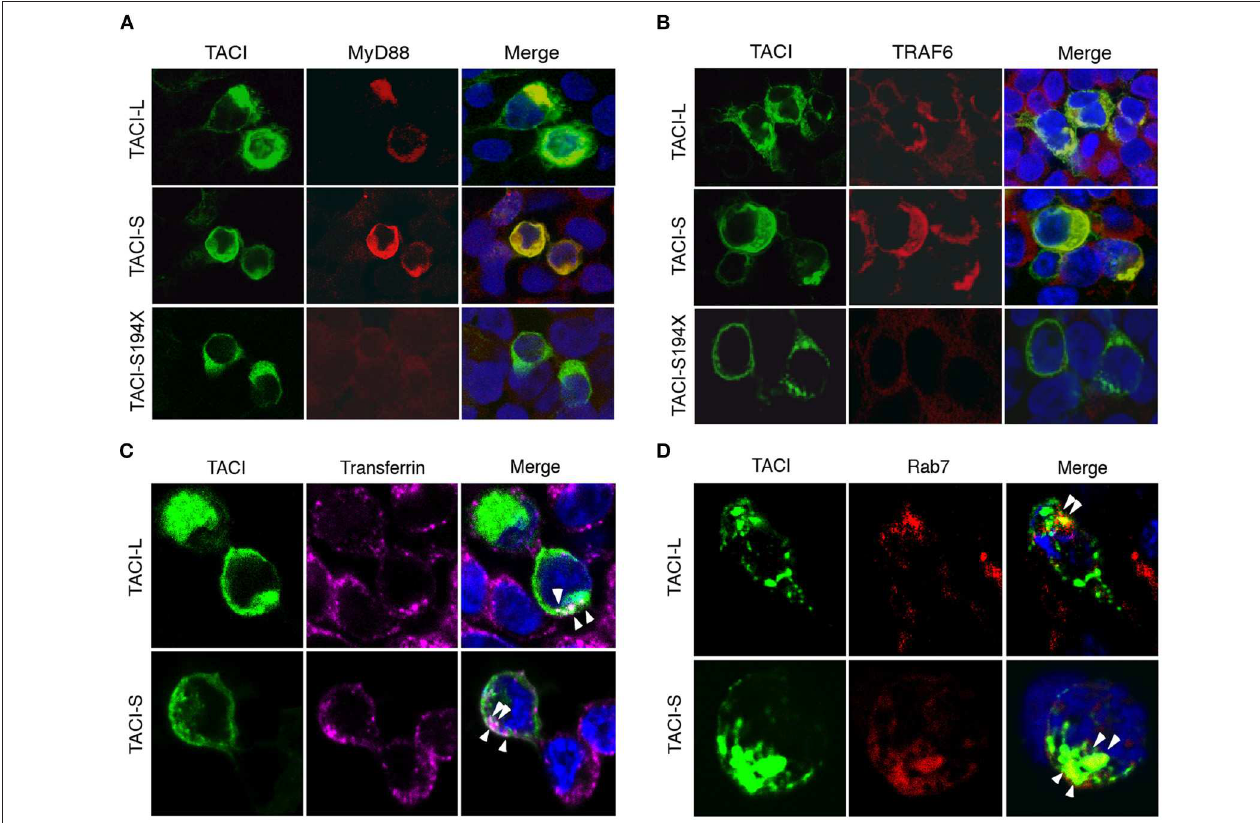
FIGURE 5 | TACI co-localizes with MyD88 and TRAF6 in the late endosomal compartment. (A) mCherry labeled TACI-S, TACI-L or TACI-S194X isoform transfected HEK-293T cells, were stained with rabbit Ab to MyD88 or TRAF6; nuclei were stained with DAPI. Merged images show that each TACI isoform co-stains with MyD88 (A) and TRAF6 (B) , but colocalization is absent for the S194X mutant. (C) HEK-293T cells transfected with mCherry labeled TACI-L and TACI-S were incubated with Alexa Fluor 647-conjugated transferrin (40 µ g/ml Tfn-647) at 37 ◦ C for 5min fixed with 4% paraformaldehyde. Merged images show that both TACI-L and TACI-S co-localize with Tfn-647 (white arrows). (D) In other experiments, transfected HEK-293T cells were stained with mAb Rab7 as a marker of late endosomes, also showing co-localization. Samples were examined by Leica SP5 DMI confocal microscopy, acquiring 3 different xy planes with 63 × /1.4 NA objective lenses (Carl Zeiss) with optimal z spacing ( ∼ 0.016 µ m). Images were processed using Adobe